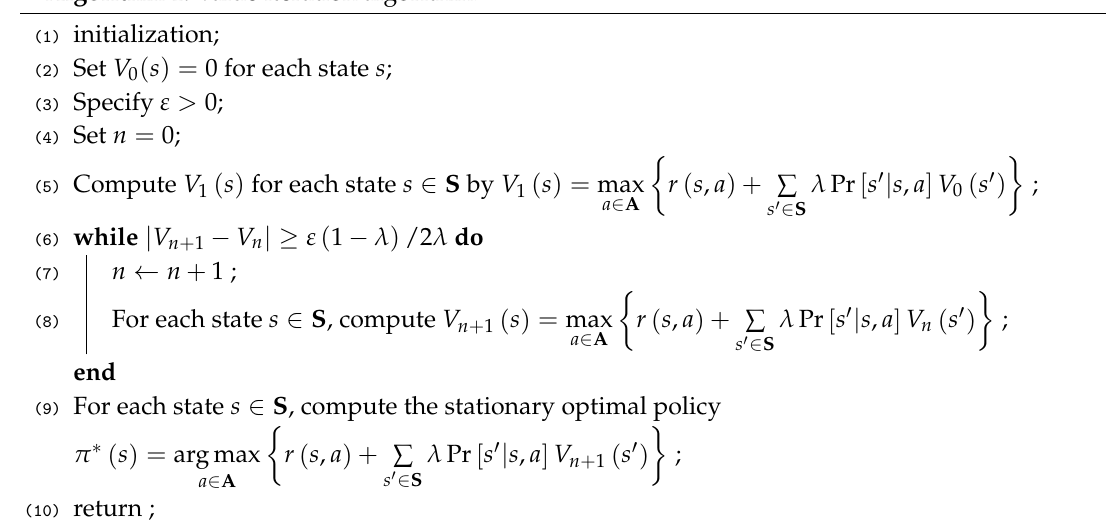
Algorithm 1: Value iteration